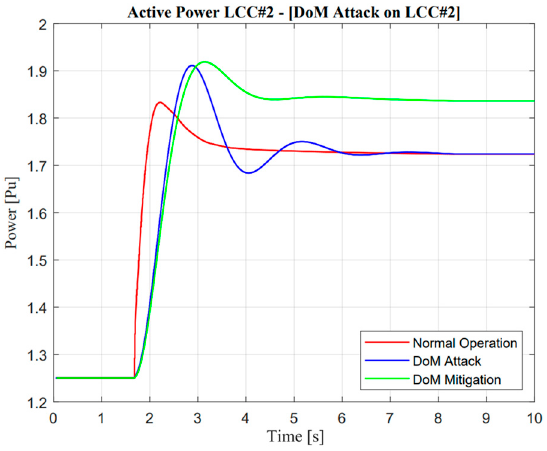
Figure 18. LCC active power response in the delay of measurement attack operation.